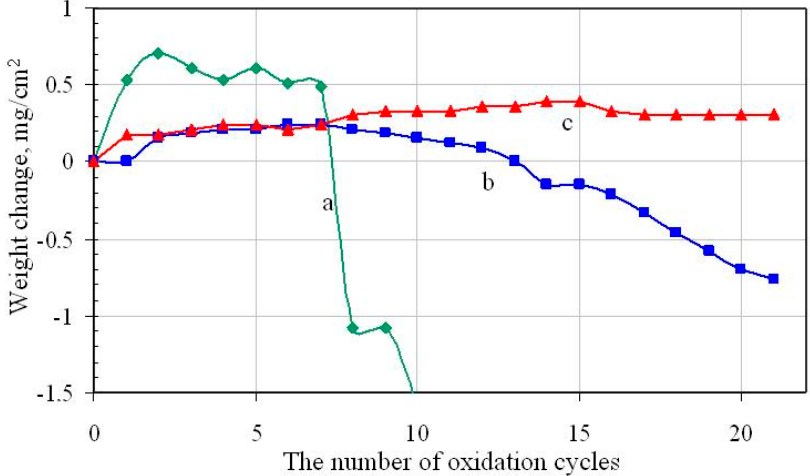
Figure 10. Oxidation test results of the nonmodified ( a ), rhodium-modified ( b ), rhodium- and hafnium-modified ( c ) aluminide coatings. Table 2. Chemical composition of the hafnium-rich particles.